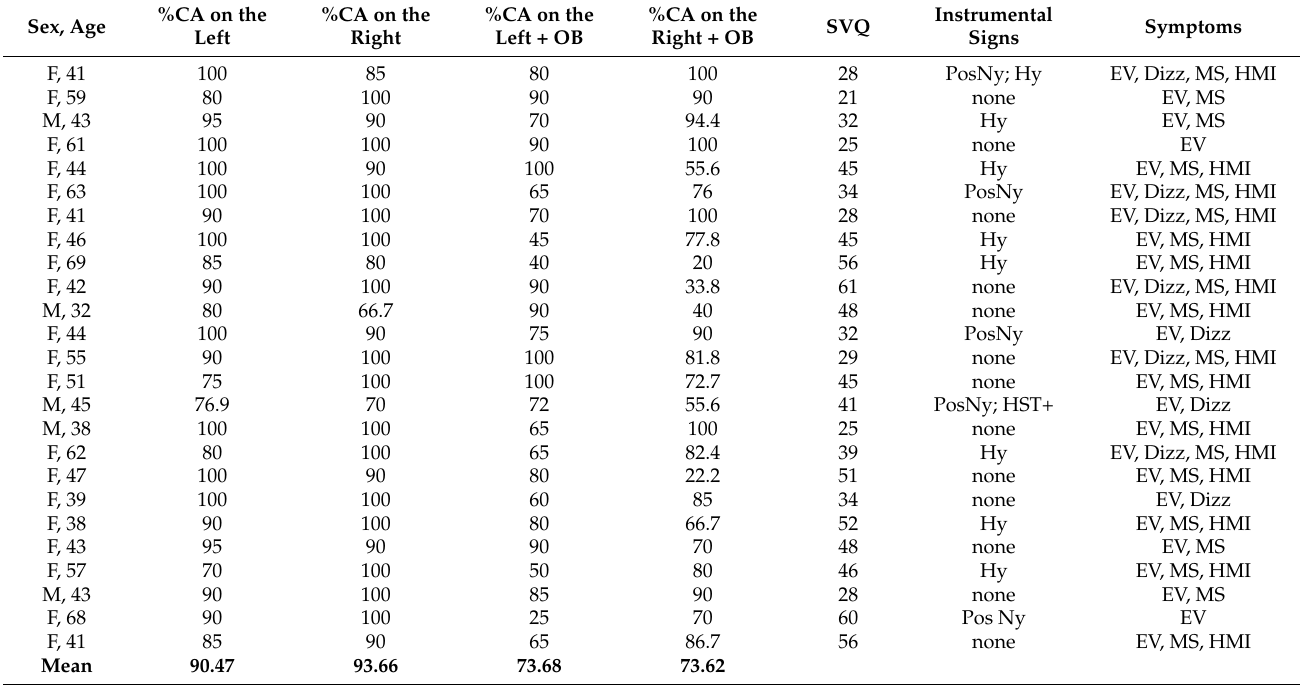
Table 1. The vestibular migraine group (VM): demographic data, clinical features, distribution of percentage of correct answers (%CA) on the left and right sides without and with the optokinetic background (OB), and situational vertigo questionnaire (SVQ) score. EV, episodic vertigo; Dizz, dizziness; MS, motion sickness; HMI, head motion intolerance; Hy, hyperreflexia; PosNy, positional persistent nystagmus; HST+, positive head shaking